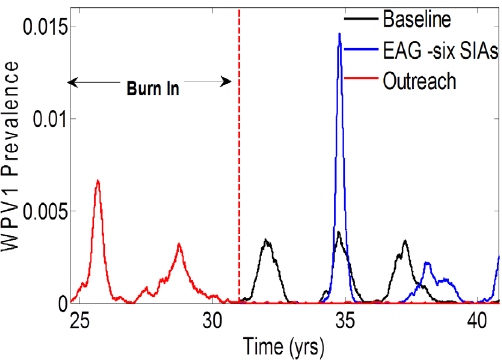
Figure 3. Temporal dynamics of WPV1 prevalence for the most likely set of calibration parameters under baseline conditions, EAG campaigns, and outreach